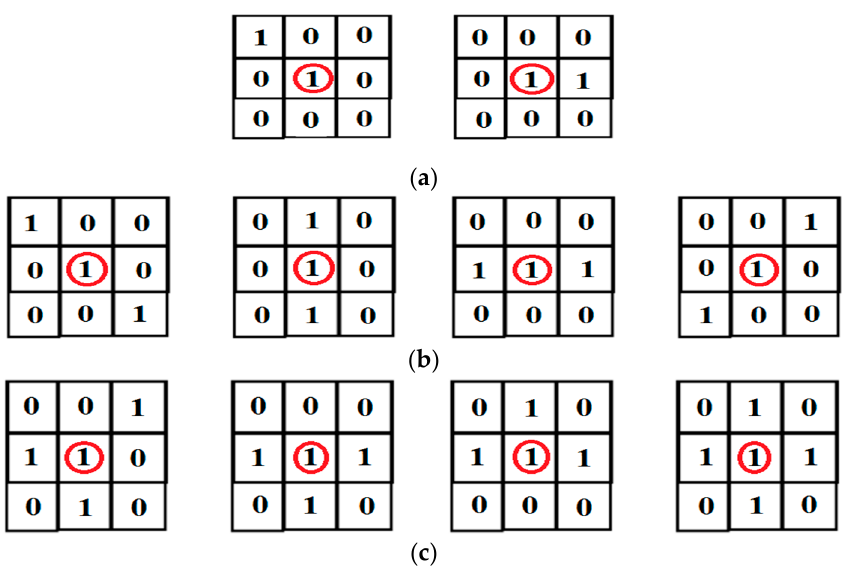
Figure 4. Pixel classification (the red circle represents the active pixels): ( a ) Endpoint; ( b ) Inner point; ( c ) Bifurcations point.